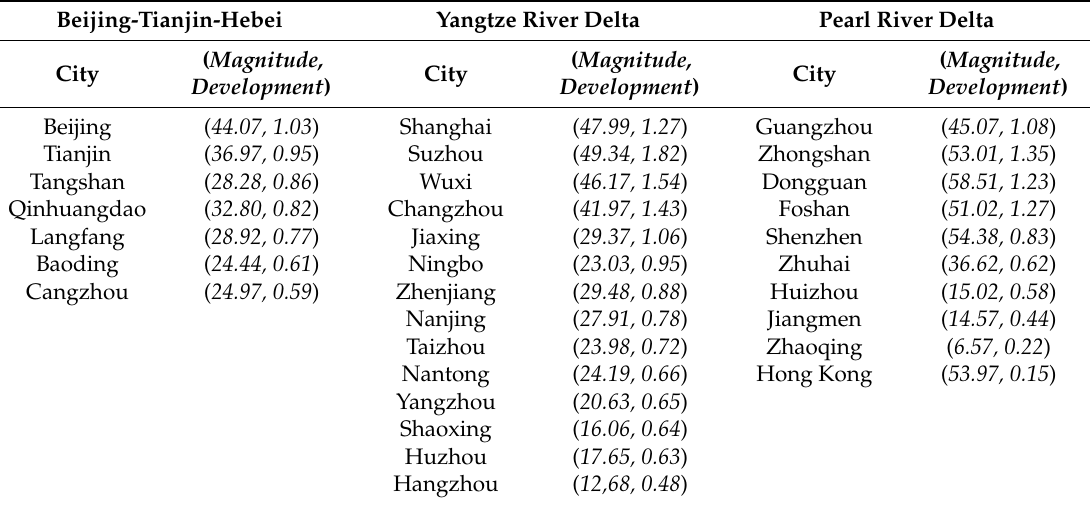
Table 2. The( magnitude, development )-diagramsinunitsof( DN,DN/yr